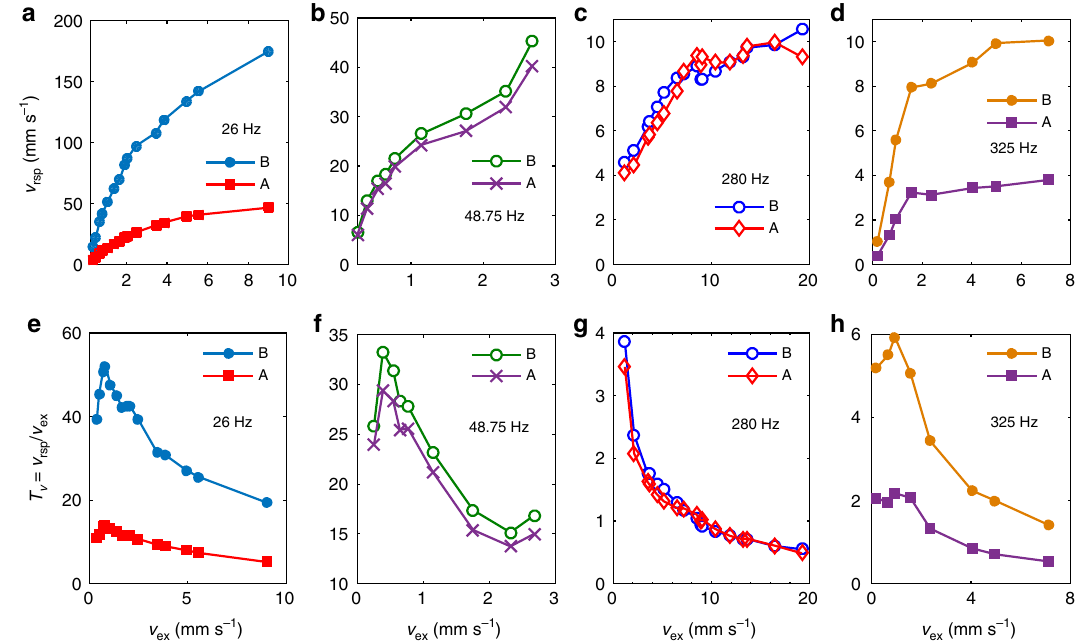
Fig. 6 Steady responses of the NAM plate. a – d Steady response amplitudes v rsp and e – h the corresponding transmissions T v at points A and B changing with v ex under four frequencies 26, 48.75, 280 and 325 Hz in the fi rst, the second and the third passbands, as labeled in Fig. 5a. In each legend, the frequency indicates that the diagram is relevant to this frequency and A (B) denotes v rsp or T v at point A (B) under that